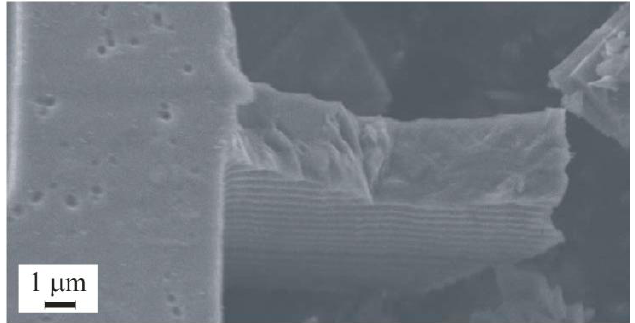
Figure 2. Failure at the connection between anchor and suspension spring of a uni-axial MEMS accelerometer, after [20].